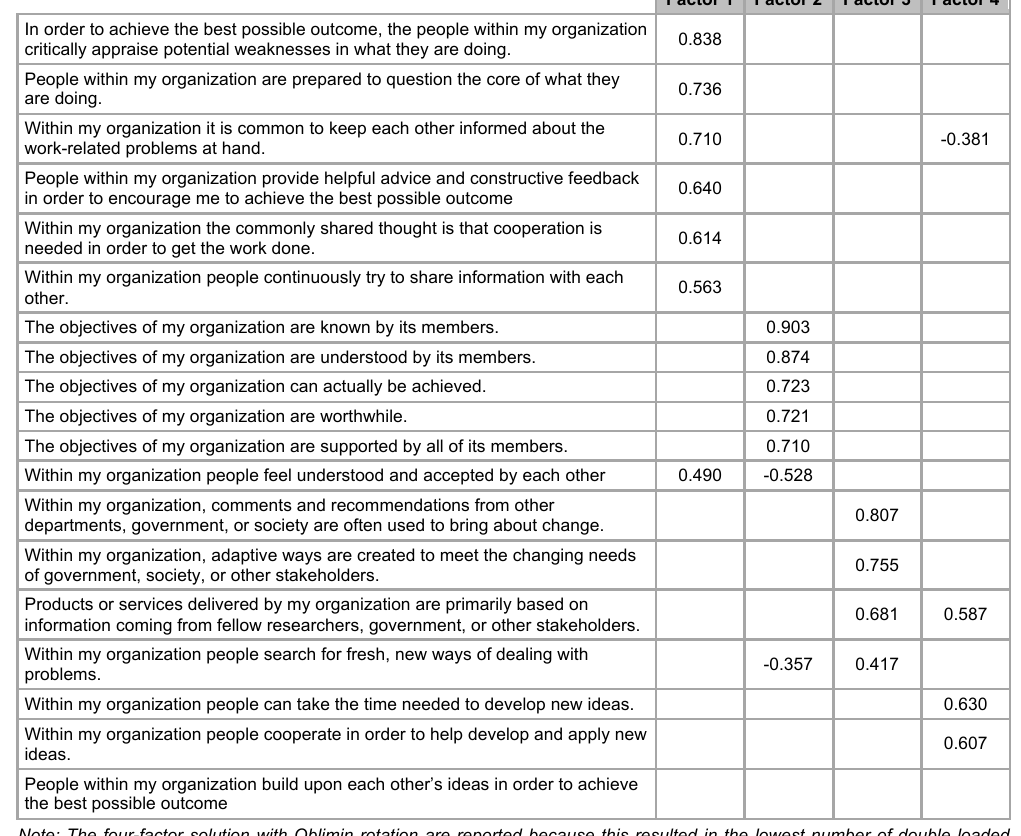
Factor loadings of items measuring organizational culture